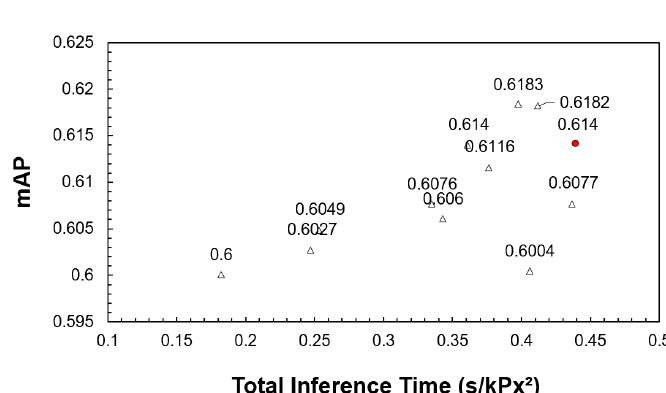
Figure 10. Total inference time (s/kPx 2 ) versus detection performance (mAP) of cluster-guided cropping strategy, which explores the speed/accuracy trade-off. The plotted values are mAP of top-N experimental cells sorted in descending order of mAP. Although some top experimental cells show similar performance as the uniform cropping, we can obtain comparative benefits in terms of the total inference